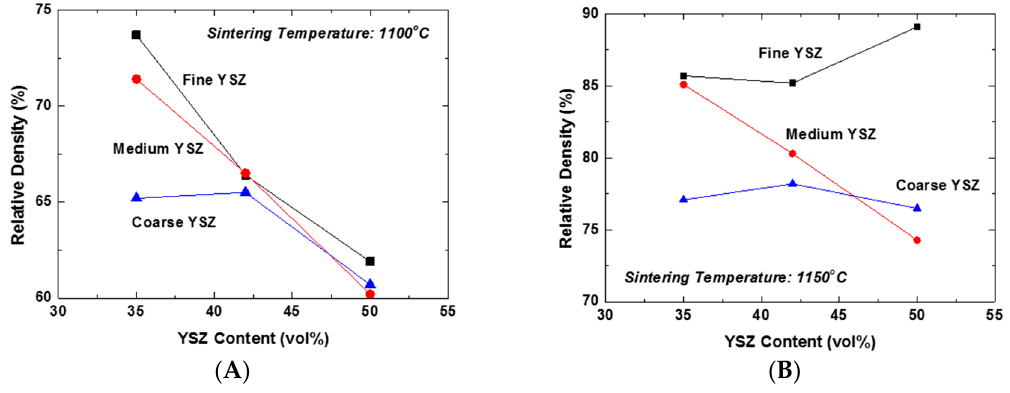
Figure 2. Relative density of LSM-YSZ composites as a function of YSZ content and particle size of YSZ sintered at ( A ) 1100 and ( B ) 1150 °C.